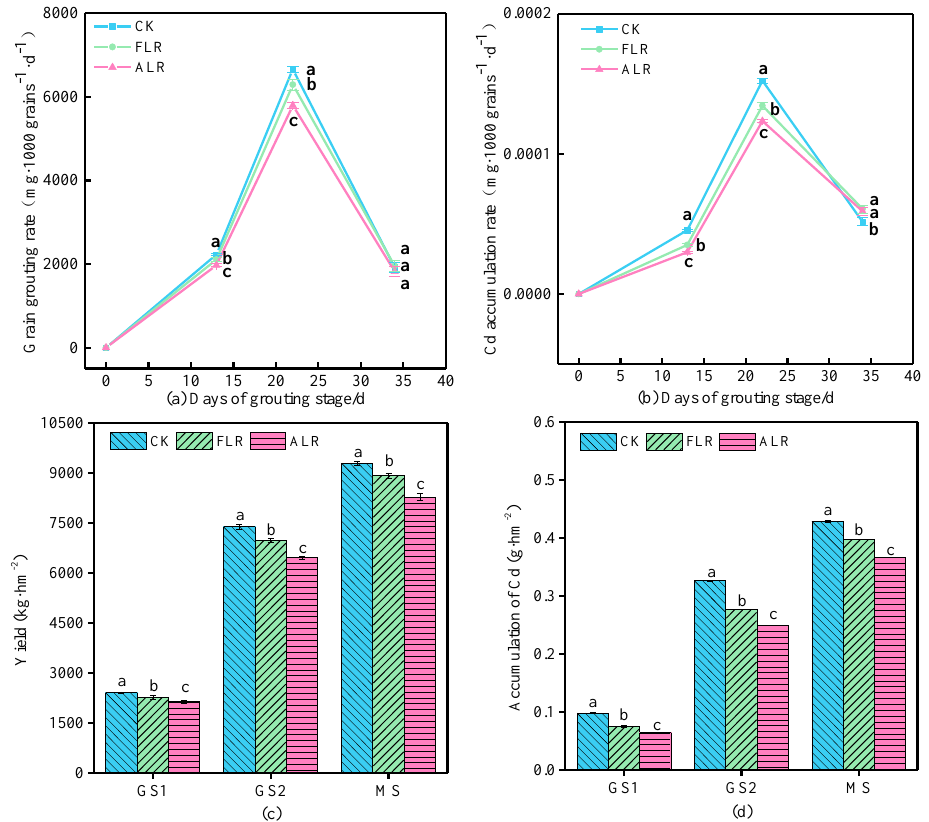
Figure 5. Grain filling rate ( a ), Cd accumulation rate ( b ), wheat yield ( c ), and accumulation of grain Cd ( d ). Note: Different letters (a, b, c) indicate significant differences ( p < 0.05) between CK, FLR, and ALR in the same stage.